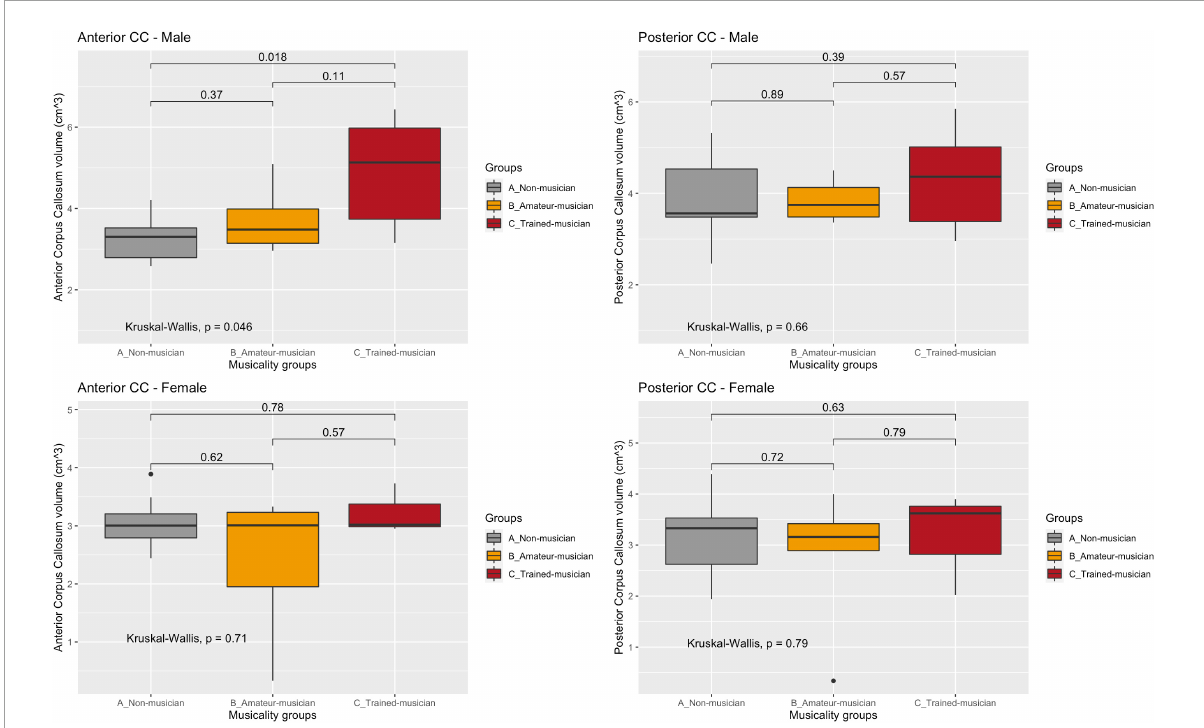
FIGURE2 Corpus callosum regions vs. musicality per sex. CC, corpus callosum. Sub-analyses in sex and subregion revealed the largest trend in the anterior corpus callosum of male non- vs. trained musicians (A: 3.28/0.621 vs. C: 4.90/1.41, p = 0.05). No trend was observed in women nor in the posterior corpus callosum.